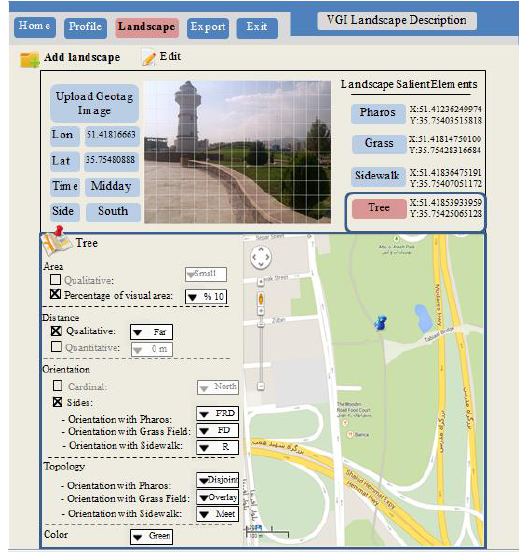
Figure 2. The web-based platform designed to collect the crowdsourced landscape descriptions